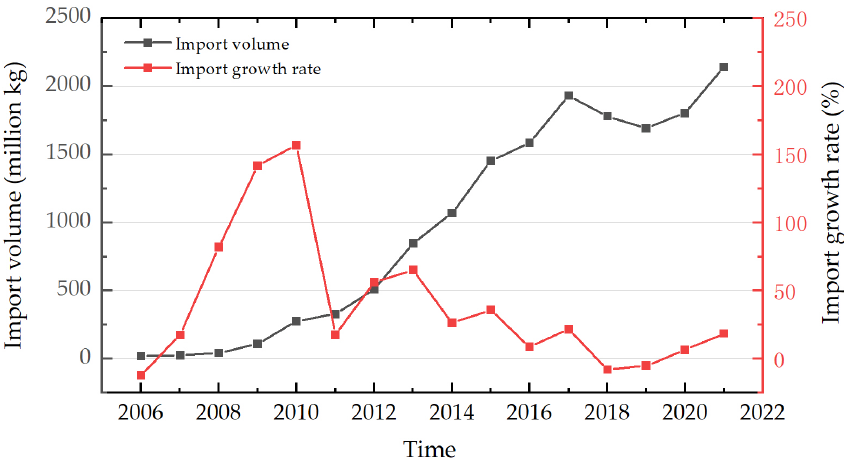
Figure 1. Import volume and import growth rate of forage products. Imports of forage products are divided into two categories: forage grass and forage seed. The vast majority of imports are forage grasses, which account for more than 95% of the import share of forage products in the past five years. Import of forage grasses into China mainly comes from the United States (with imports in 2021 reaching 1.43 million tons, accounting for 70.14% of the total imports of forage grasses), followed by Spain and Australia, with imports of 274,366 tons and 212,156 tons, respectively; these three exporters account for 90% of China’s total imports. Forage grasses are also imported from South Africa and Canada. Forage seed trade partner countries are more scattered, mainly from the United States, Denmark, and